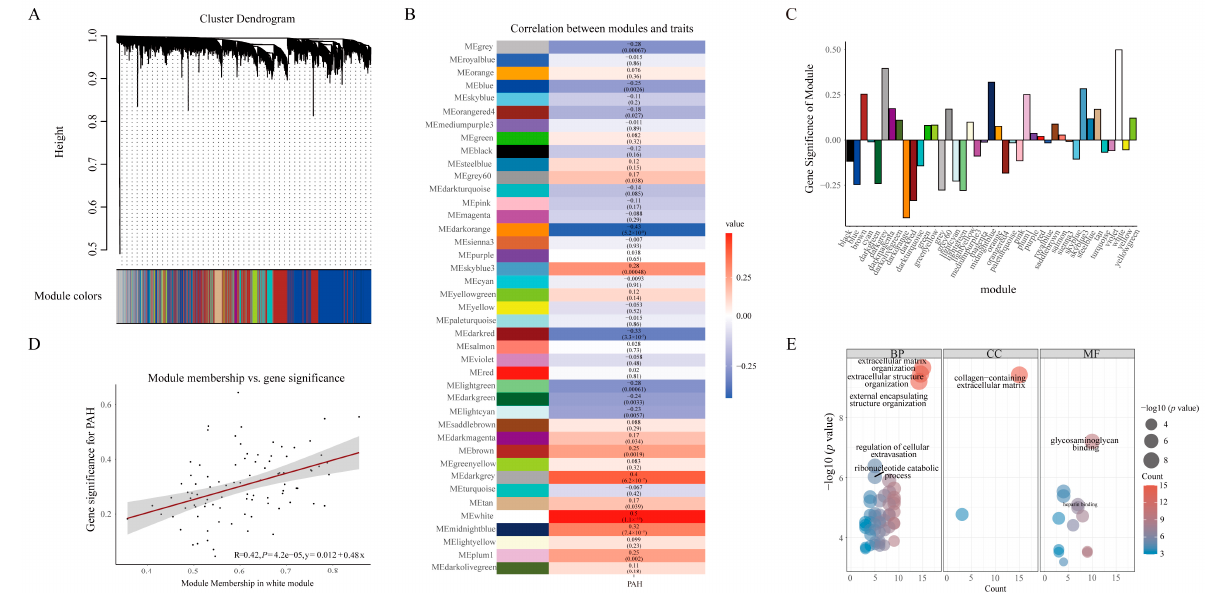
Figure 2. The module detection with WGCNA. ( A ) Clustering dendrogram plot of PAH and normal lungs. ( B ) Heat map of the correlation between modules and traits. ( C ) Gene significance (GS) bar plot of modules. ( D ) Module membership (MM) and the gene significance (GS) correlation plot. ( E ) GO enrichment analysis of white module genes. BP: biology pathways; CC: cell component; MF: molecular function.